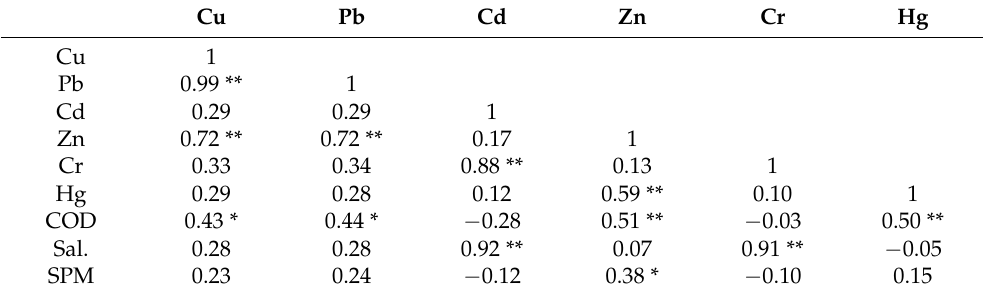
Table 2. Person correlation matrix for total heavy metal concentrations and the physicochemical parameters in sea ice. Cu Pb Cd Zn Cr Hg Cu 1 Pb 0.99 ** 1 Cd 0.29 0.29 1 Zn 0.72 ** 0.72 ** 0.17 0.33 Hg 0.29